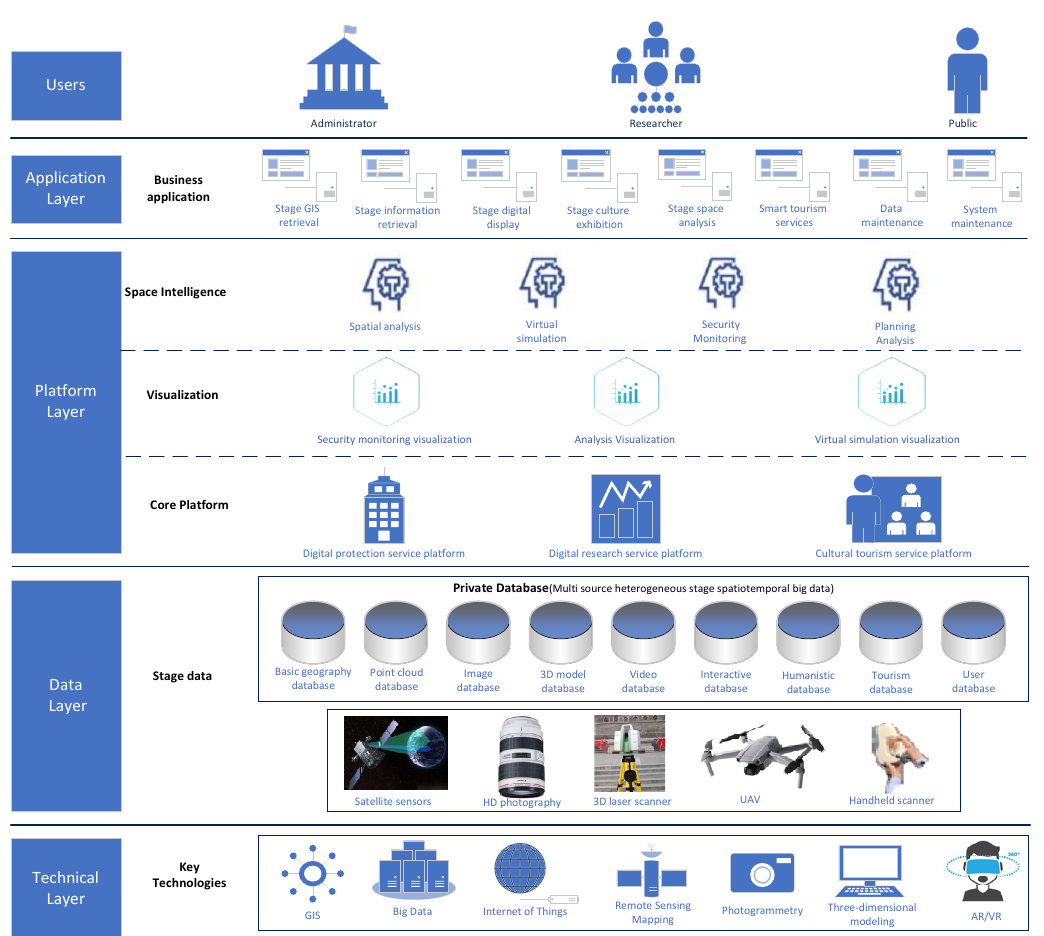
Figure 4. The structure of the